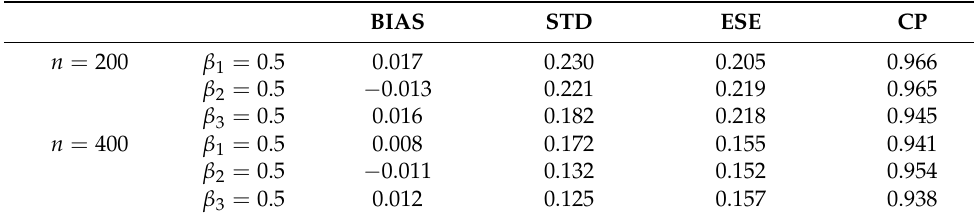
Table 3. Simulation results for ( β 10 , β 20 , β 20 ) = ( 0.5,0.5,0.5 ) .